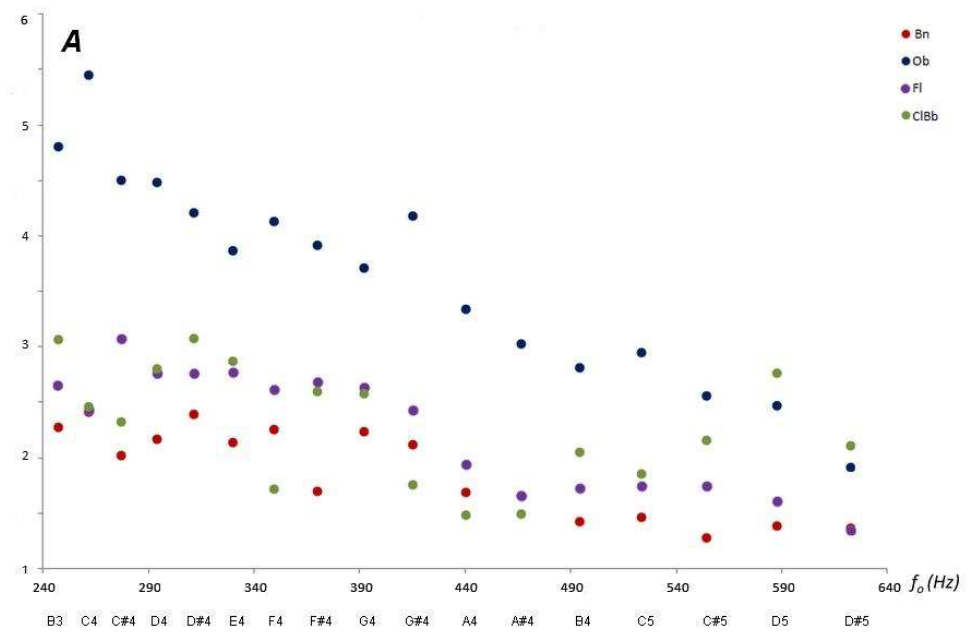
Figure 4. Variation of Affinity A in the selected sample of aerophones.